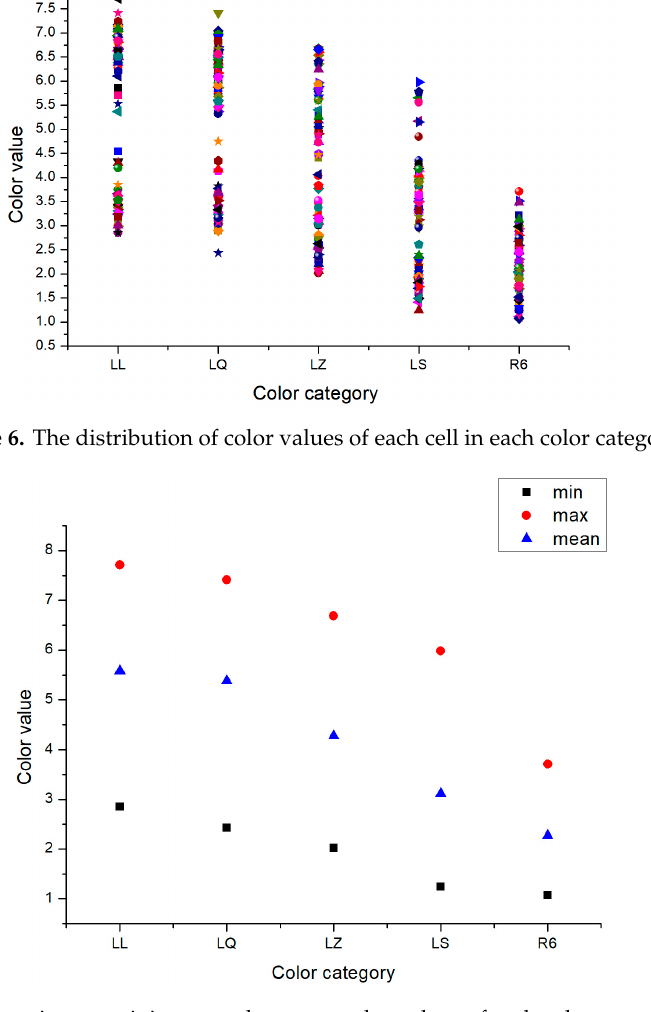
Figure 7. The maximum, minimum and average color values of each color category of cells.